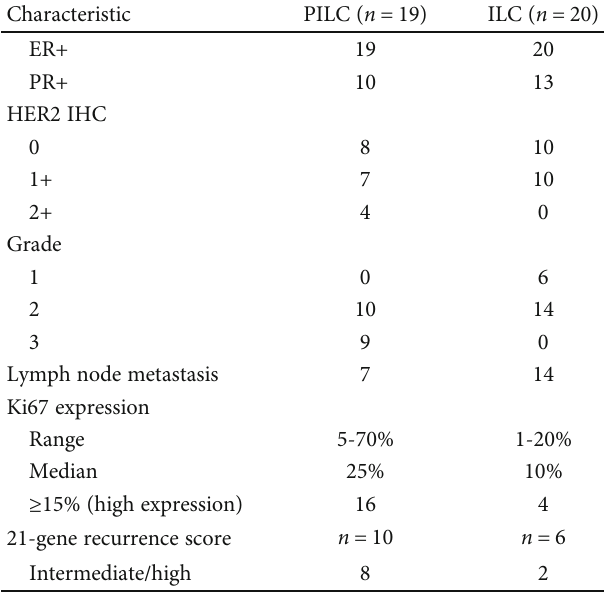
Table 1: Histological characteristics of PILC and ILC tumors.